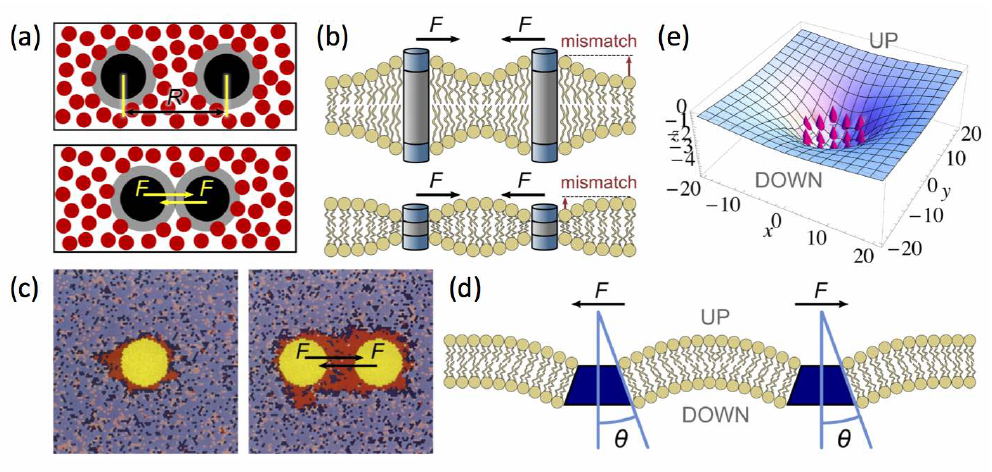
Figure 7. Illustrations of some of the inter-protein forces (denoted by F on this figure) propagated by the lipid membrane. ( a ) Depletion forces due to the lateral osmotic pressure exerted by lipids (red discs) on the proteins (black). The pressure becomes anisotropic when the distance between proteins is smaller than the lipid size. ( b ) Hydrophobic mismatch forces resulting from the difference between the thickness of the membrane hydrophobic layer (the hydrocarbon chains) and the height of the protein hydrophobic cores (in gray) ( c ) Wetting-induced interaction: when the membrane is made of a lipid mixture, a single protein (left panel) nucleates a “halo” of “wetting” lipids (in red). When two proteins get closer (right panel), their halos overlap, which reduces the interfacial energy between lipid species. A force ensues. ( d ) Mutual interaction felt by two up-down non-symmetric inclusions (in blue) and propagated by the deformable elastic membrane. The asymmetry is schematized by the conical shape of inclusions. It is measured by the cone half-aperture angle θ . ( e ) Collective deformation of the membrane by an assembly of up-down non-symmetric inclusions (pink cones). Figures reproduced from [9], with permission from Elsevier, Copyright